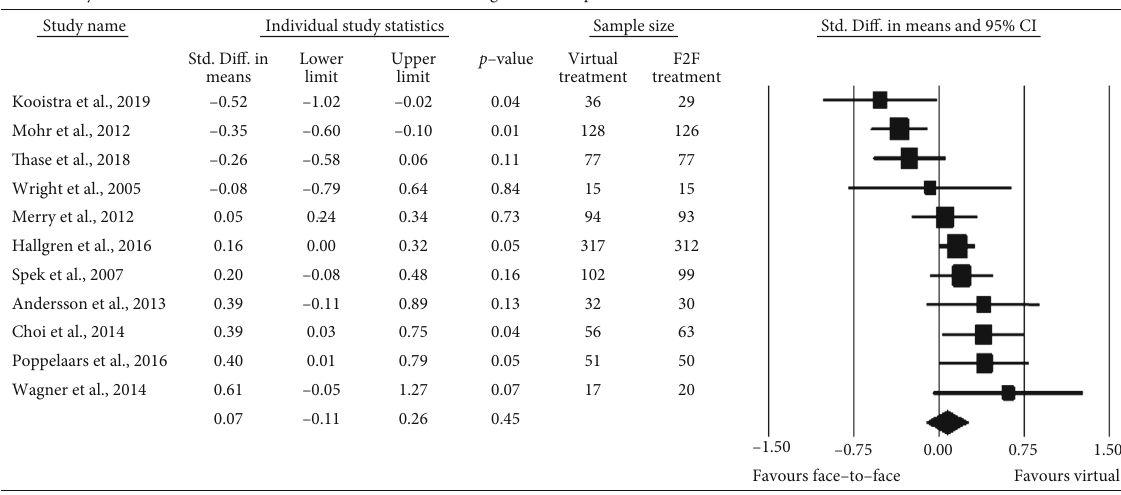
Figure 3: Critical follow-up comparisons of virtual and F2F